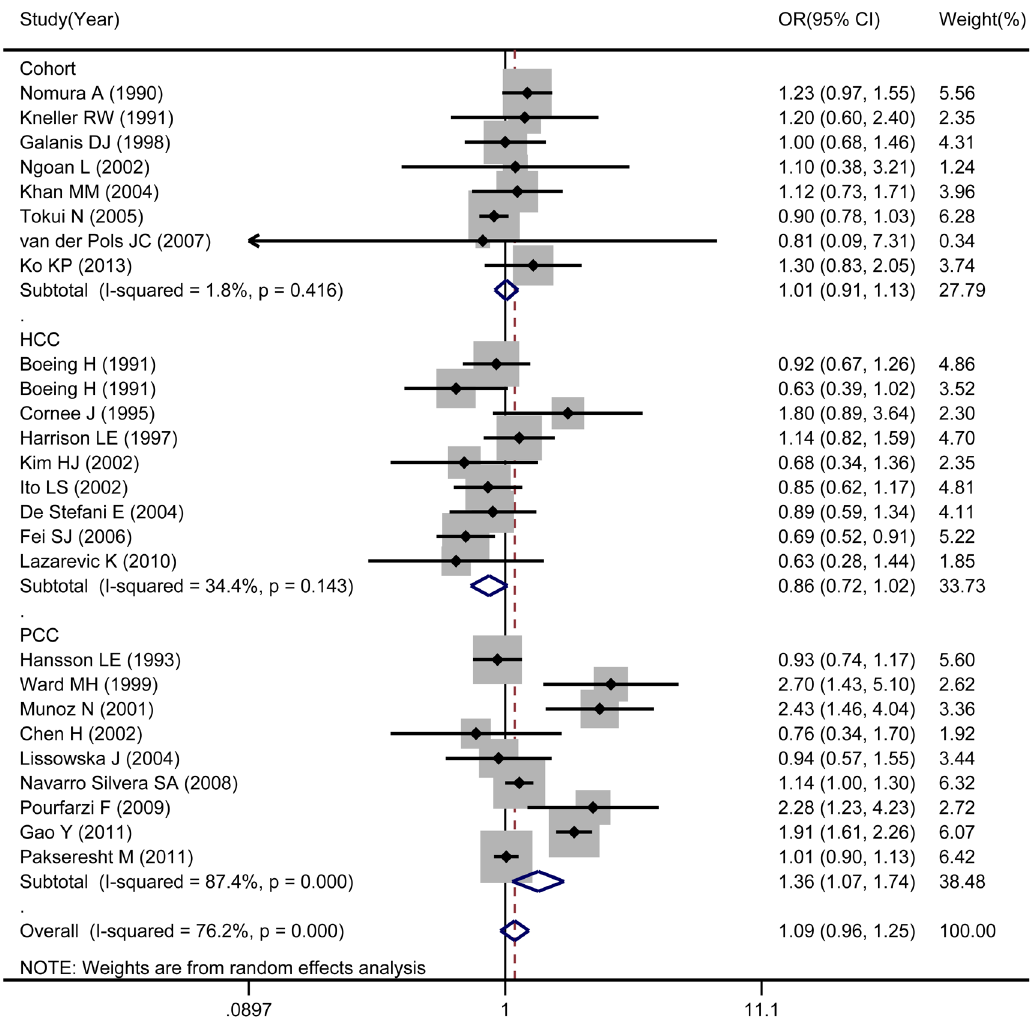
Figure 2. Consumption of total dairy foods in association with gastric cancer.